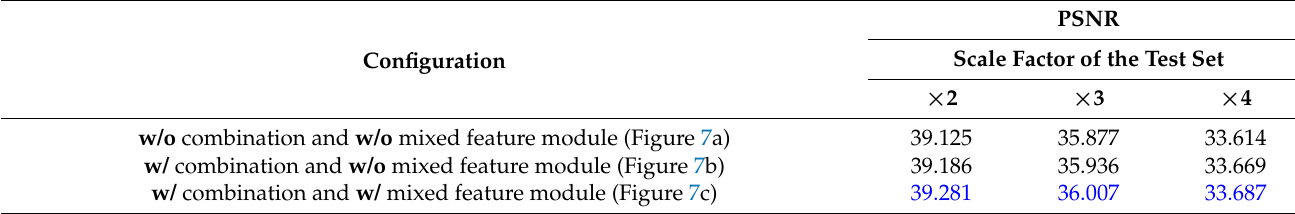
Table 3. Performance comparison w.r.t. the combination module and the mixed feature module (blue-colored: the best case).